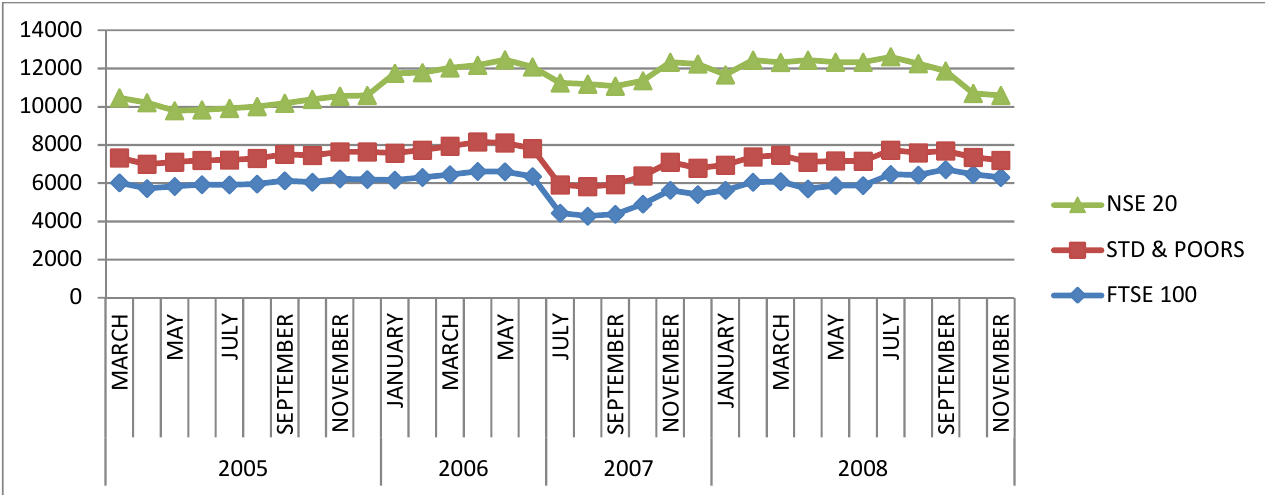
Fig. 7. Pre and Post Crisis Influence of the Performance of NSE 20 Share Index on Standard & Poor Index Table 2 Descriptive Statistics on the Relationship Amongst NSE 20 Share Index, FTSE 100 and Standard & Poor’s During the Pre and Post Crisis Period Mean Std.